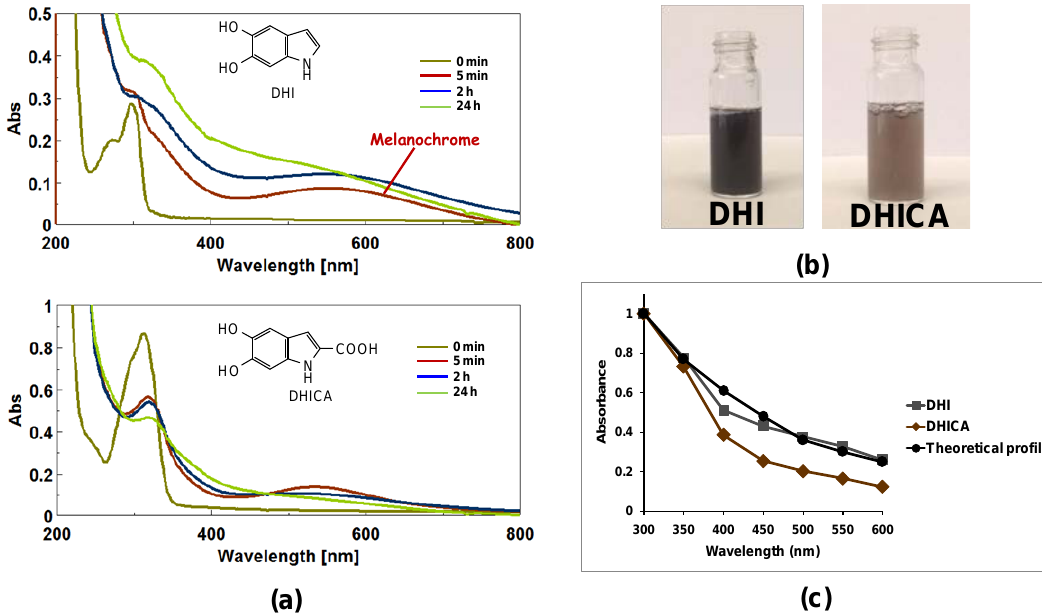
Figure 2. Melanin chromophore from 5,6-dihydroxyindole (DHI) or 5,6-dihydroxyindole-2-carboxylic acid (DHICA) oxidation. ( a ) Time course of DHI ( top ) or DHICA ( bottom ) aerial oxidation; ( b ) Final appearance of the mixture of DHI or DHICA after 24 h oxidation; and, ( c ) Relative absorbance of the melanins from the indole compounds over the UV-visible region in the presence of 1% poly(vinyl alcohol) (PVA) against the theoretical monotonic profile [53].